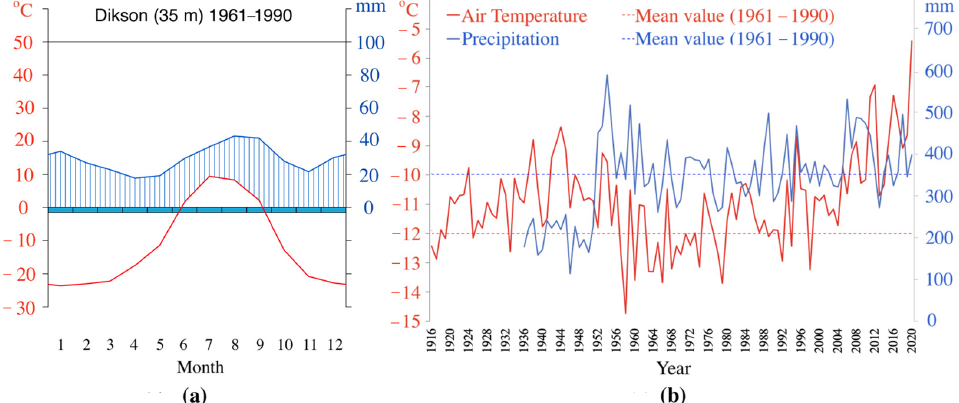
Figure 2. Walter and Leith climate diagram that illustrates precipitation and temperature changes throughout the year in one standardized chart ( a ); long-term record of mean annual air temperature and mean annual precipitation at the weather station “The Island of Dikson” (WMO ID: 20674) ( b ). Dashed lines represent mean values of the corresponding meteorological variables for 1961–1990, a period that illustrates climate conditions at the start of a warming signal caused by major anthropogenic activities and has been used by the WMO as a reference for the long-term climate change evaluations.